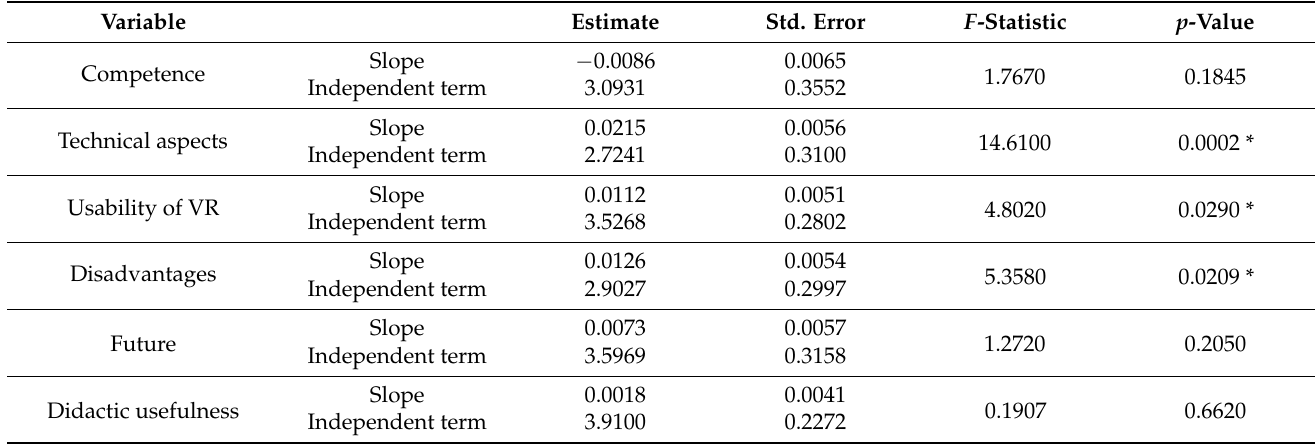
Table 7. Statistics of the linear regression model of the different factors of the questionnaire with respect to the age of the participants among the professors from public universities (270